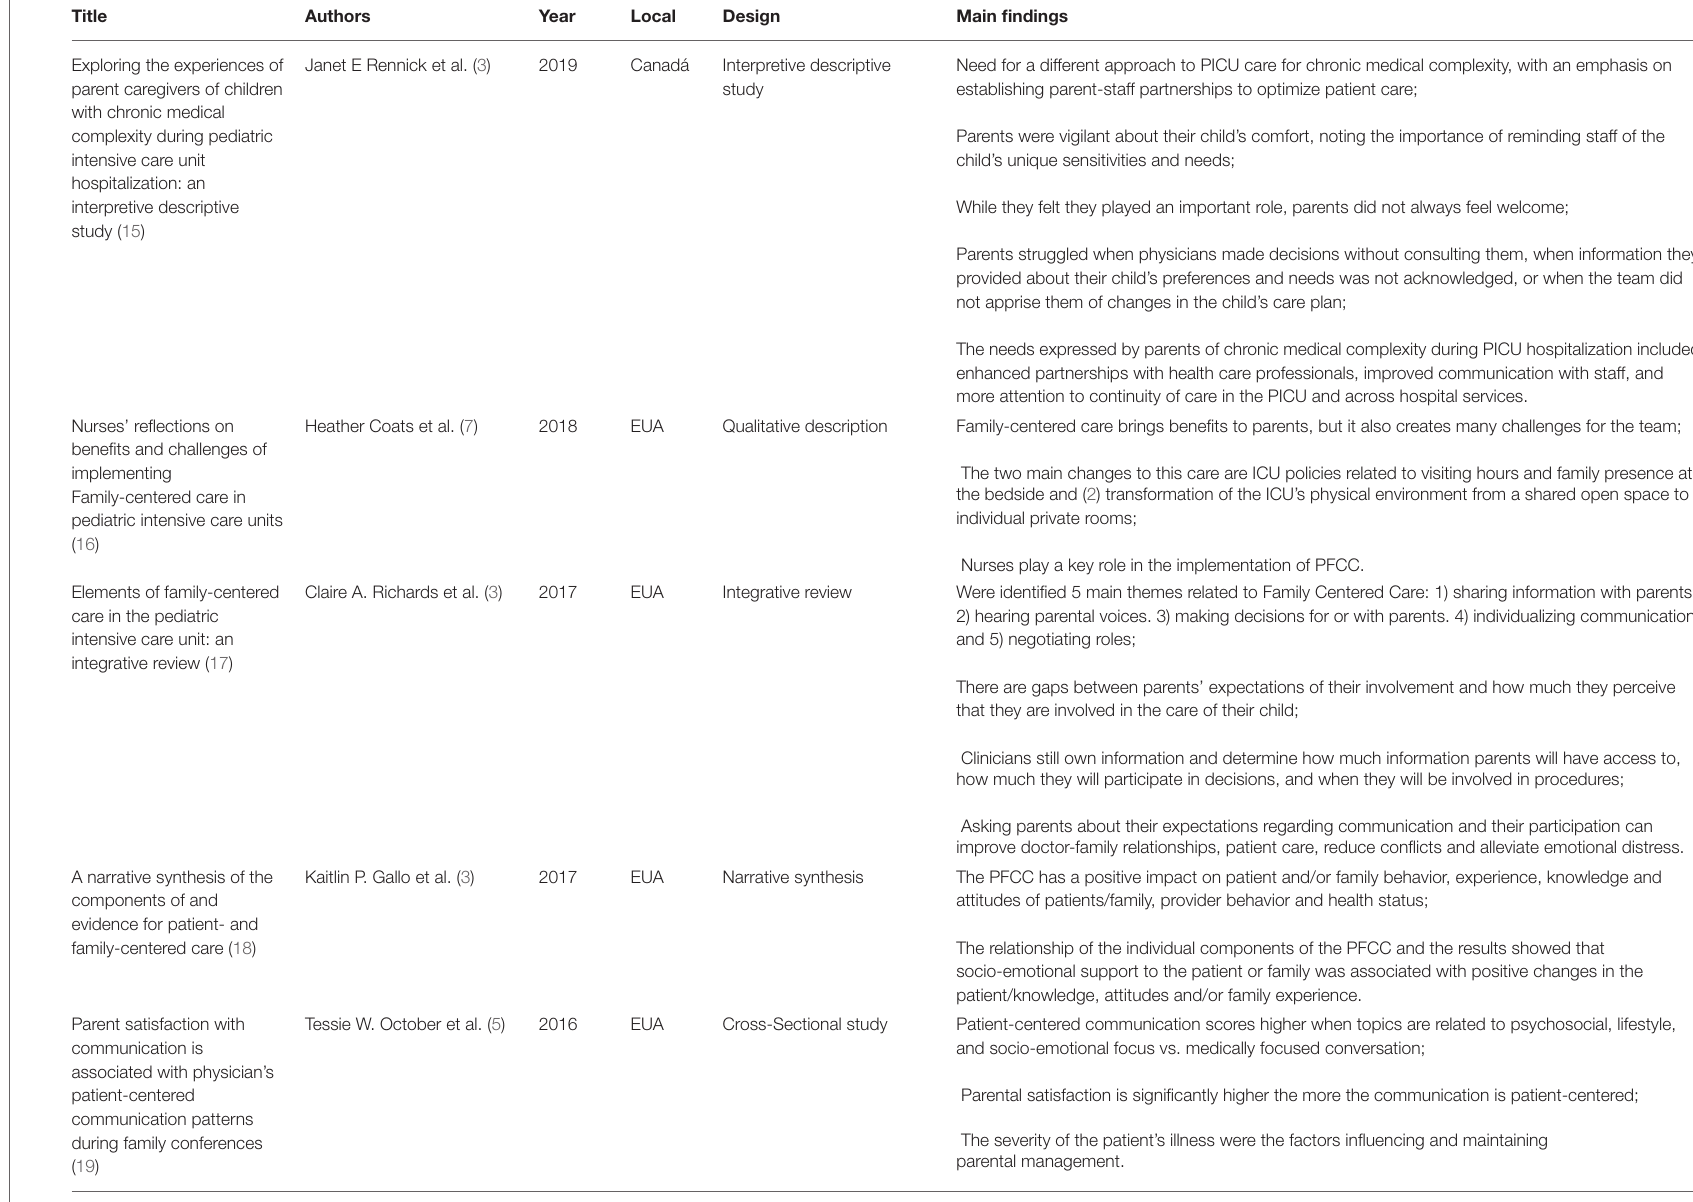
TABLE 1 | Articles on PFCC in